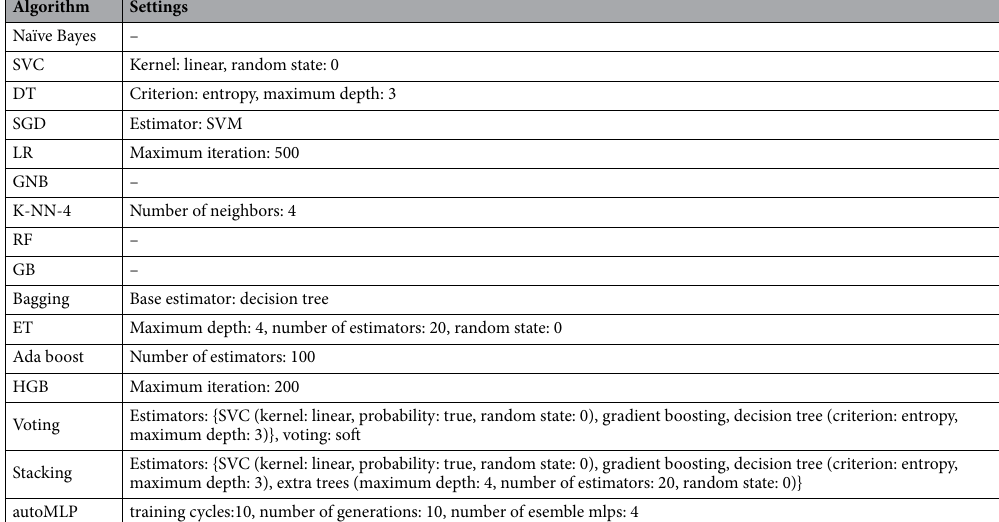
Table 1. Settings of the used